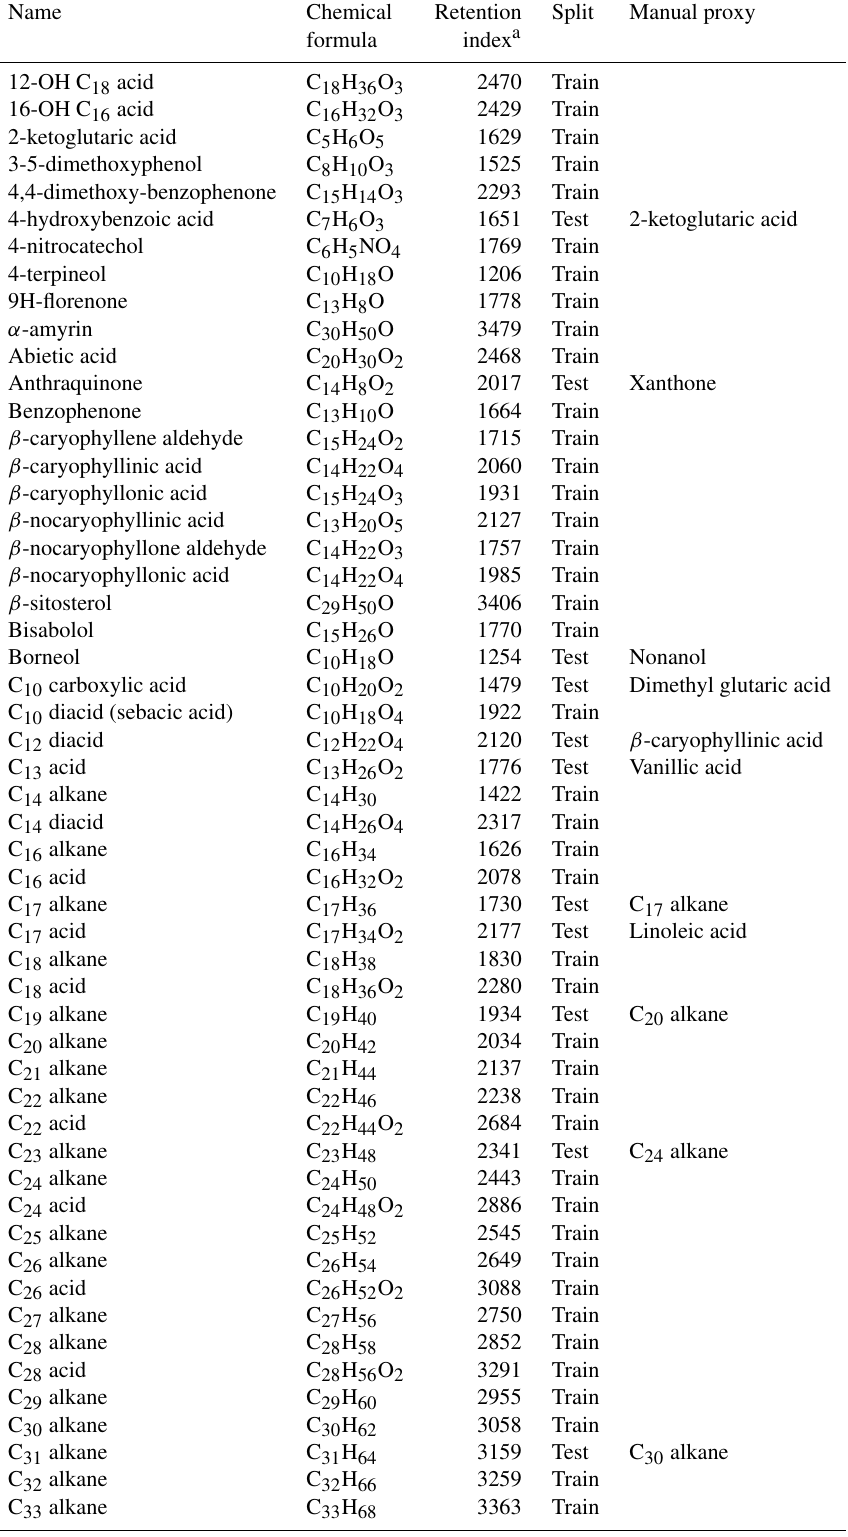
Table A1. External standard names, formulae (underivatized), retention indexes, split (training set versus test set), and manually assigned quantification